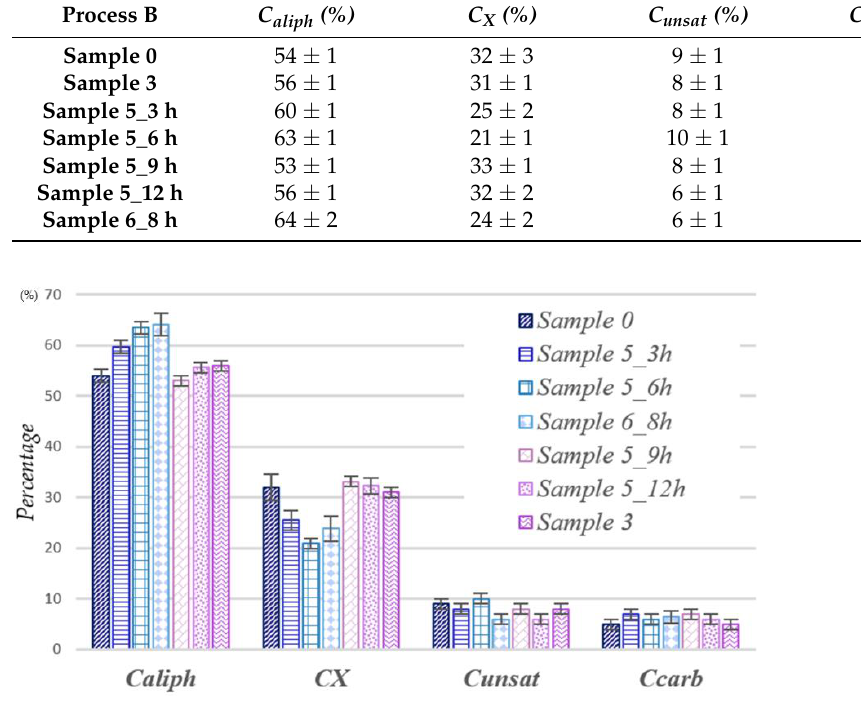
Figure 5. Relative distribution, expressed as percentage (%), of the carbon groups C aliph , C X , C unsat , and C carb for process B samples and comparison with the Sample 0 and Sample 3.